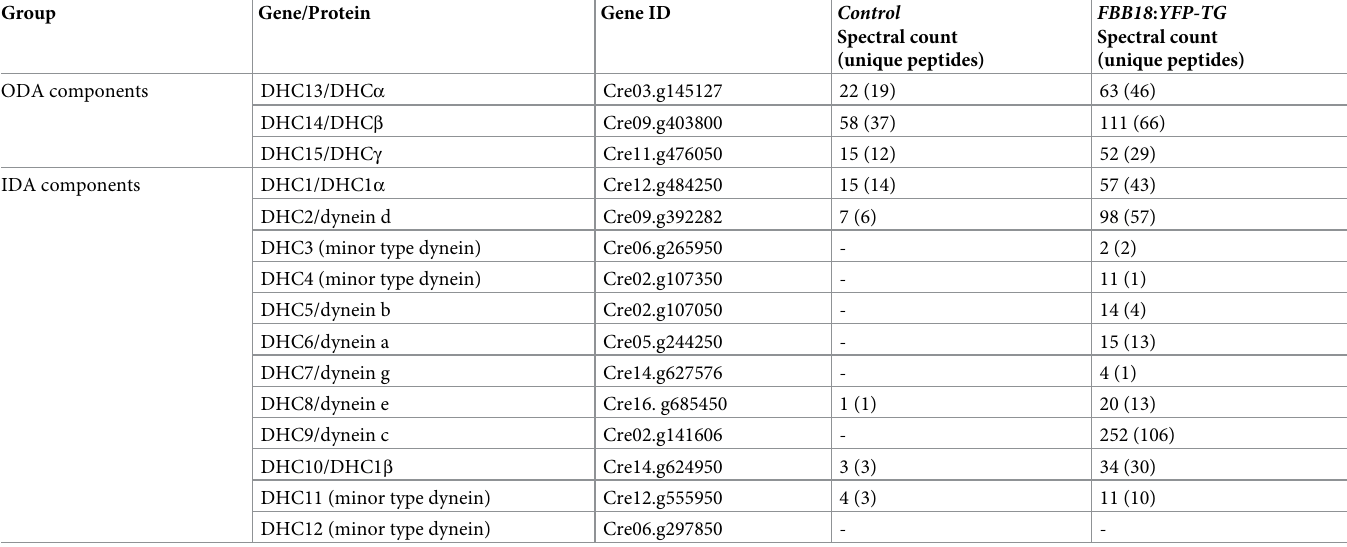
Table 2. FBB18 associates with almost all axonemal dyneins.